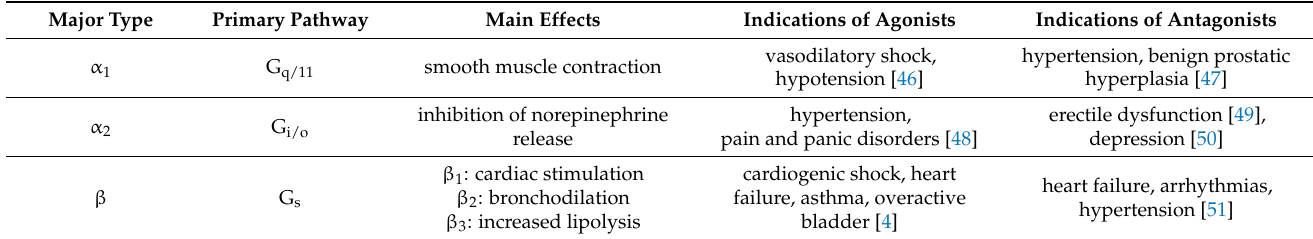
Table 1. Major types of adrenergic